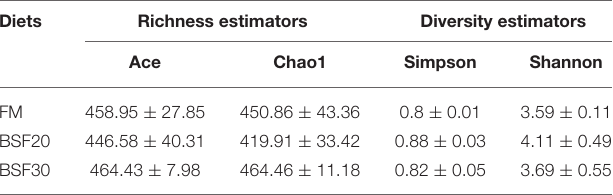
Data represent mean ± SEM of three replicates (n = 3). Values in the same row with different letters are significantly different (P < 0.05). The lack of superscript letter indicates no significant differences among